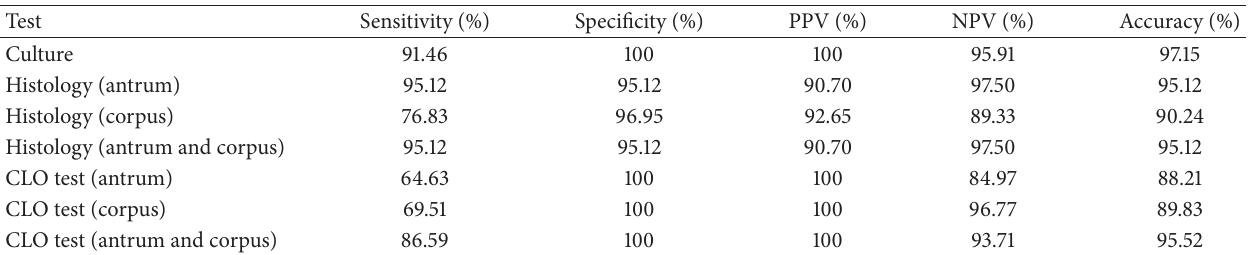
Table 4: Results of the sensitivity, specificity, positive predictive value (PPV), negative predictive value (NPV), and accuracy among the